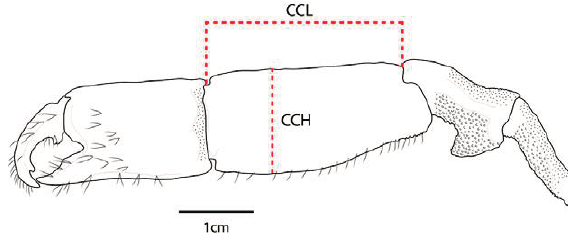
Fig. 2. – Male major cheliped used for appendicular measurements and relative growth analyses. CCH, carpus height; CCL, carpus